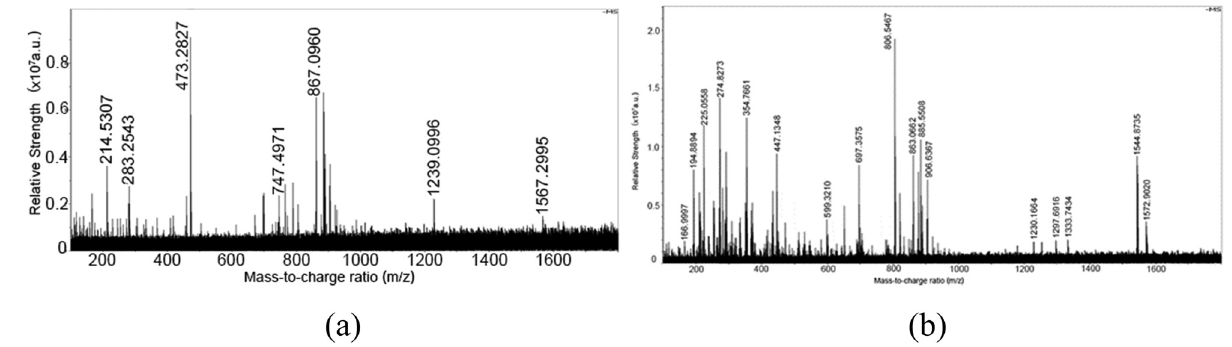
Figure 6: The negative mass spectrum of the lower layer ( a ) and the upper layer ( b ) of the sample extracted with the B&D method.